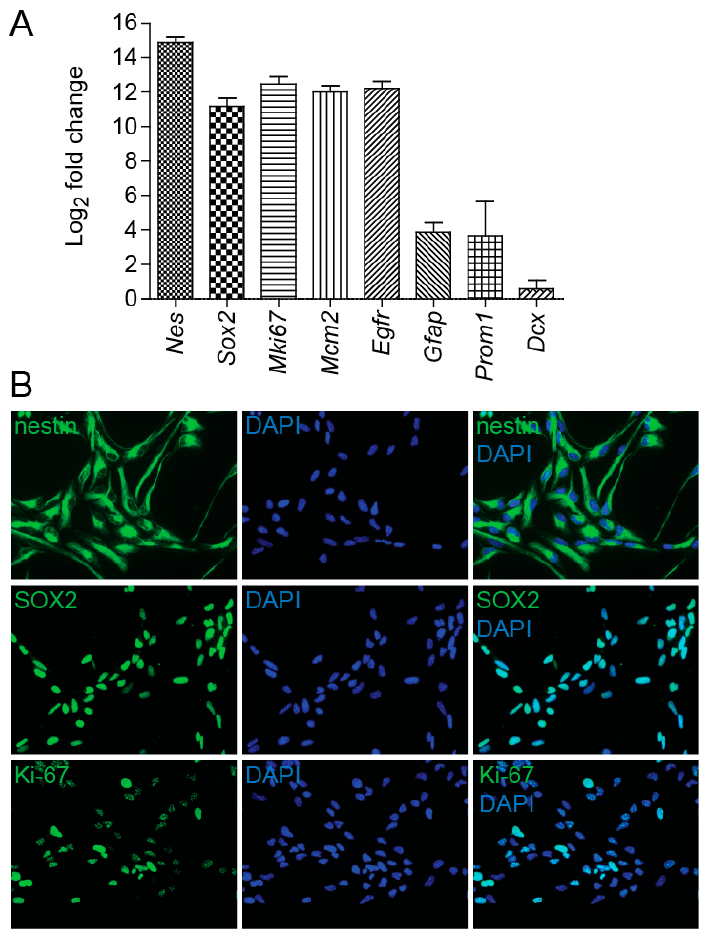
Figure 1. Neural stem cell (NSC) culture characterization. ( A ) Quantitative RT-PCR analysis of mRNA levels of marker genes in NSCs cultured in growth medium in vitro, expressed as Log 2 fold change. Gapdh was used as a reference gene. ( B ) Immunofluorescence images of NSCs stained with nestin, SOX2, and Ki-67 antibodies (green). DAPI (blue) was used to stain the nuclei. Original magnification: 400 × .